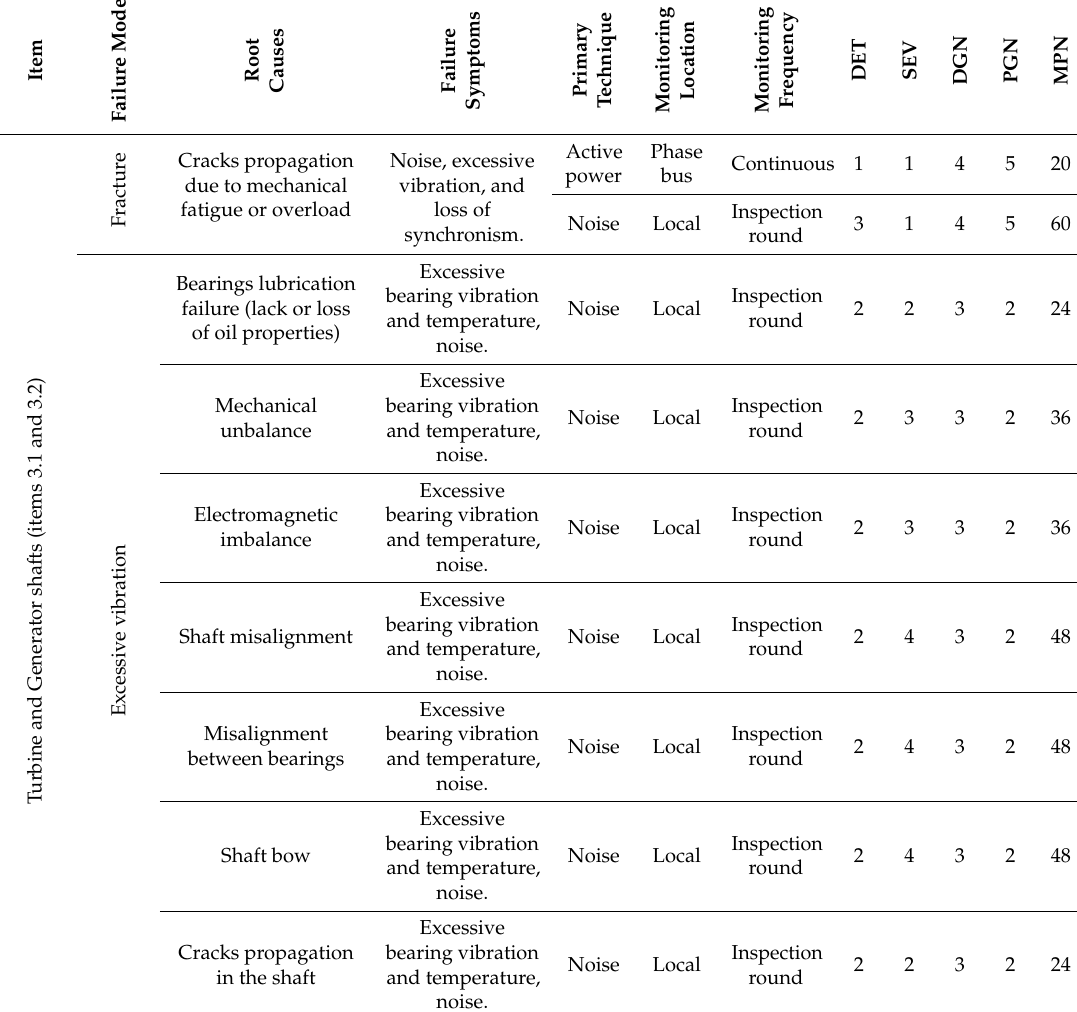
Table 9. Failure Mode Symptoms Analysis (FMSA) Worksheet